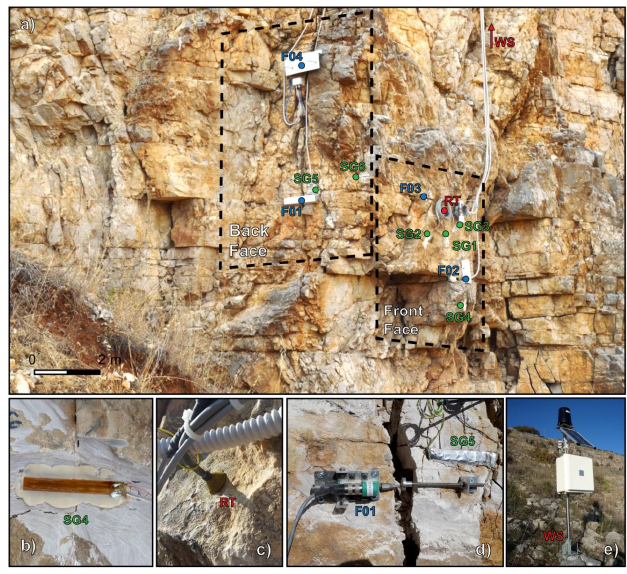
Figure 1. Monitored rock block ( a ) with both faces highlighted in the dashed boxes. Sensors installed on the rock block: ( b ) strain-gage, ( c ) type-k thermocouple to measure the rock mass temperature, ( d ) extensimeter, ( e ) weather station with a Campbell Scientific CR1000 data logger.